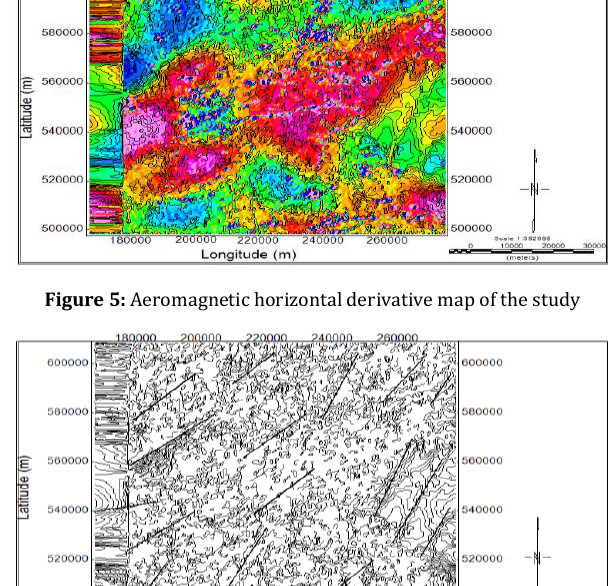
Figure 2: Total magnetic intensity (TMI) map of the study area The separation of residual and regional field from the potential field data was done by applying a first order polynomial using Oasis Montaj TM software. The residual map (Figure 3) revealed that the magnetic field intensity ranges from -52.5nT to 58.0nTindicatingcharacteristic low and high magnetic signature.